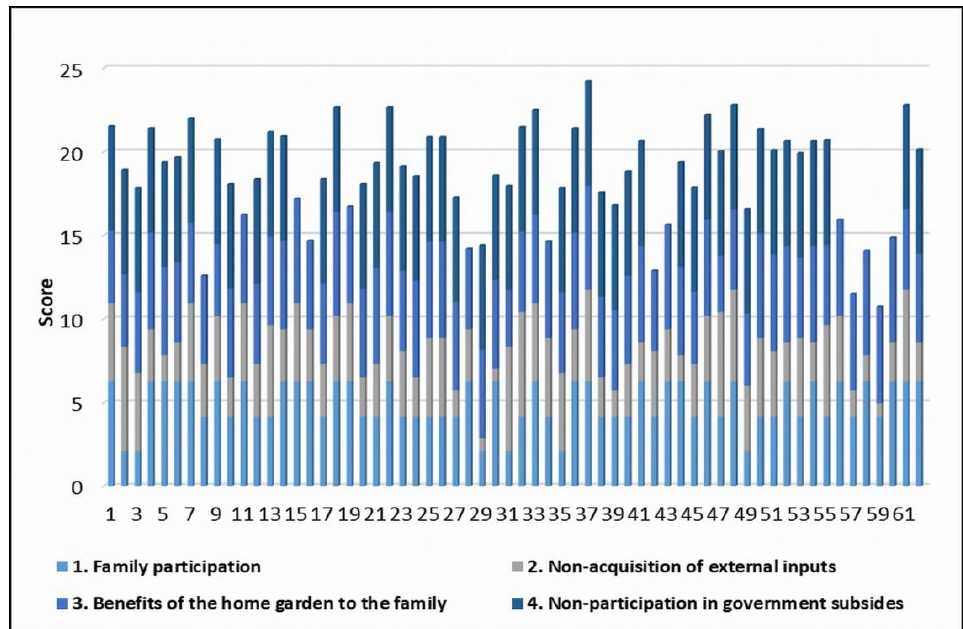
Figure 3. Accumulated value per home garden for the self-management-autonomy indi-